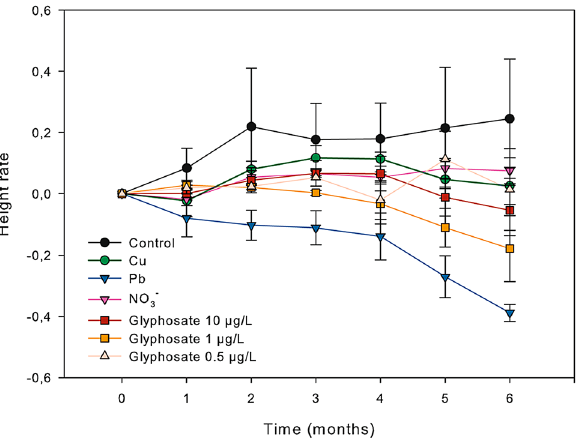
Figure 3. Mean height variation of adult individuals of Carpodesmia crinita under control conditions and the different pollutant treatments for 6 months. Height variation is given in parts per unit. Vertical bars represent standard errors.